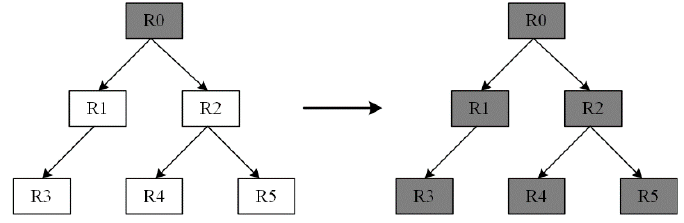
Figure 4. Rule-caching without Cover-Set.